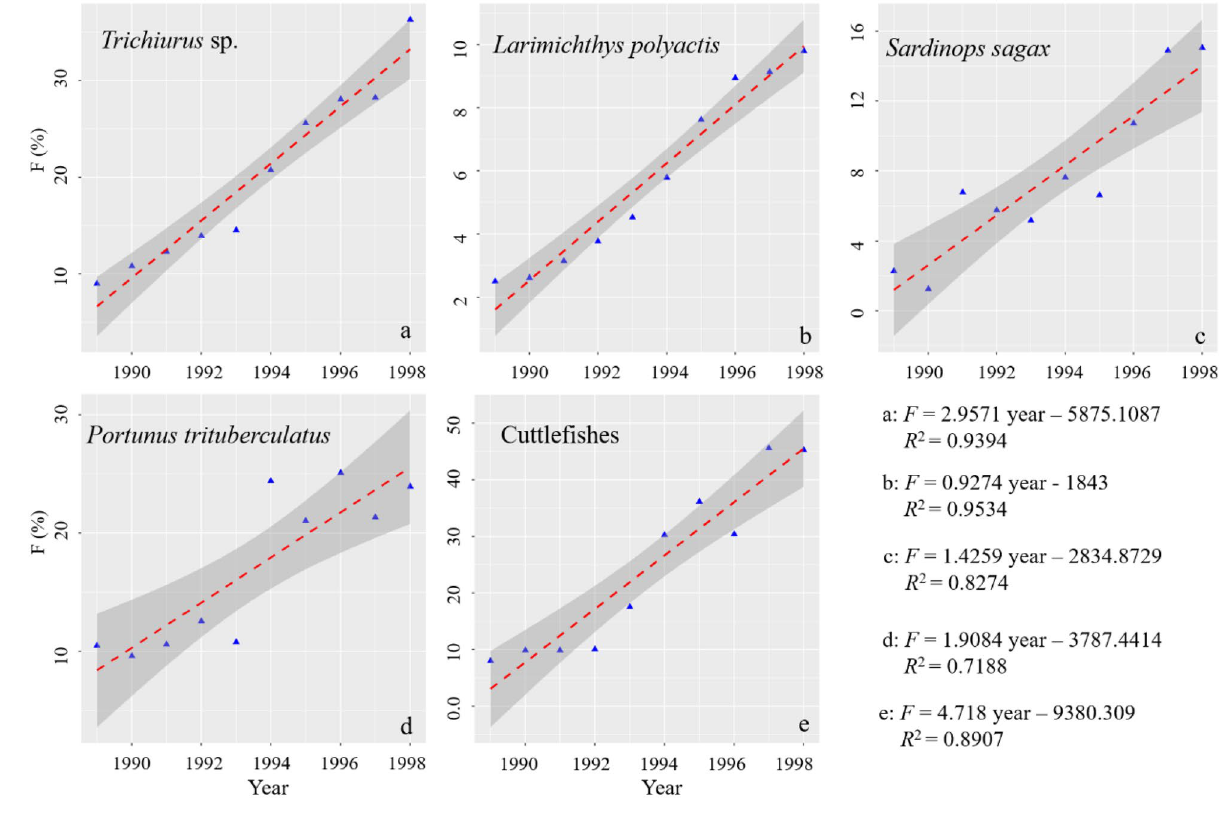
Figure 5. The trend of F without “zero-growth” policy of selected species or species